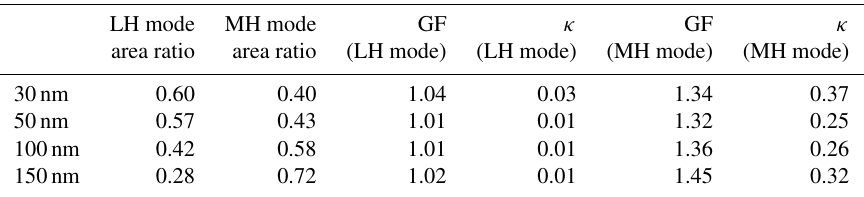
Table 2. The area ratio, GF value, and κ value for the less hygroscopic (LH) mode and more hygroscopic (MH) mode for four dry diameters for only Type 1 (externally mixed)